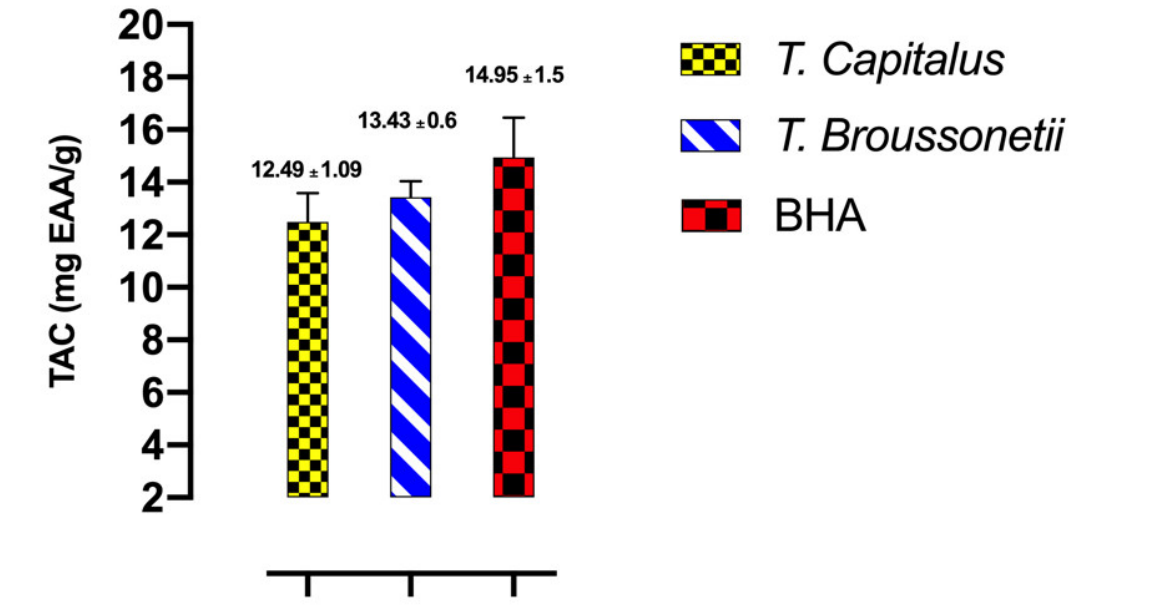
Figure 3. IC 50 and EC 50 of T. capitatus and T. broussonetii EOs and of BHA standard measured by DPPH ( 1 ) and FRAP ( 2 ) methods . Data are expressed as mean ± SD. The experiment was performed in a minimum of three replicates. *** p < 0.001 compared to the samples ( 1 ); *** p < 0.001 compared to the control BHA ( 2 ).